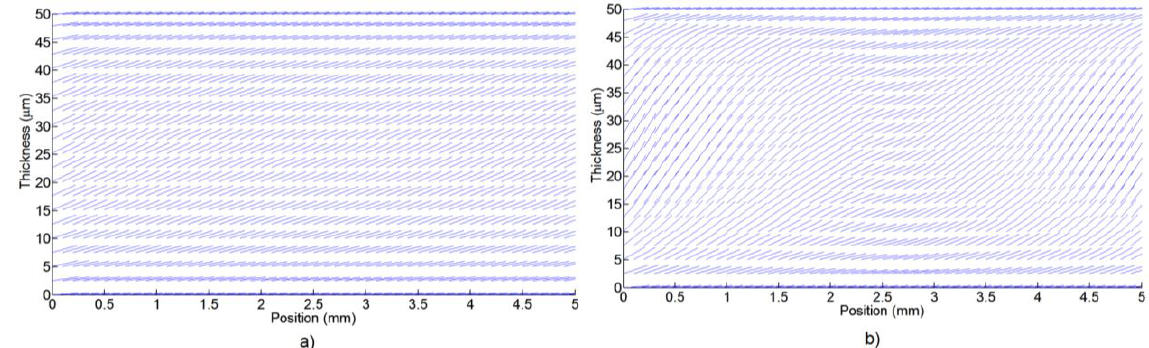
Figure 4. Molecular distribution ( XZ plane) for ( a ) a low voltage applied to the electrodes (0.1 V ); ( b ) and a higher voltage (1.3 V rms